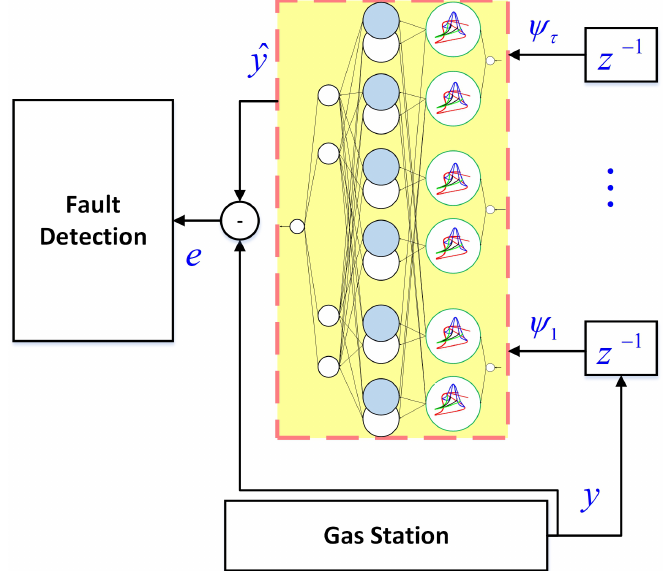
Figure 1. General scheme of the type-3 FLS fault detection